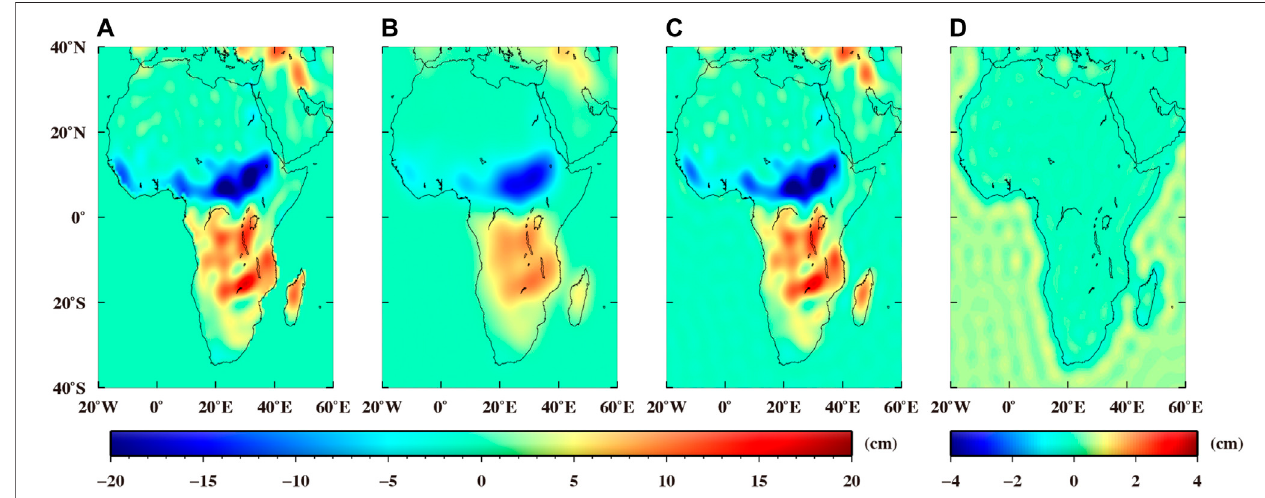
FIGURE 6 | Same as Figure 4 but derived from the improved forward modeling method.